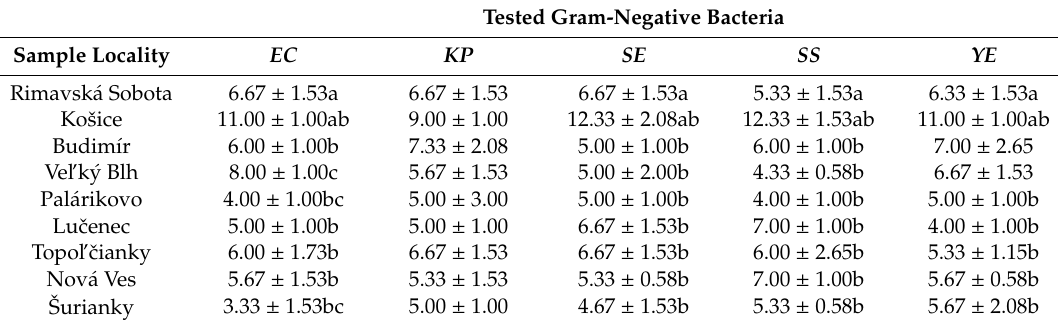
Table 3. Antimicrobial activity of Gingko biloba against Gram negative bacteria (in mm). Tested Gram-Negative Bacteria